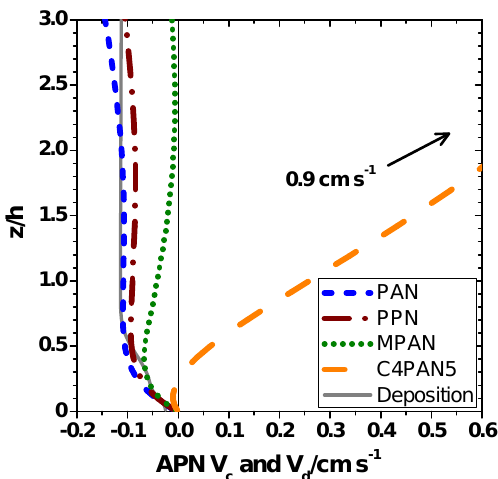
Fig. 9. Modeled chemical velocity profiles for PAN, PPN, MPAN and C4PAN5 during the hot period. The deposition velocity, which is the same for all APNs, is also shown. The chemical velocity for C4PAN5 extends off the scale (0.9cms − 1 at z/h = 3).